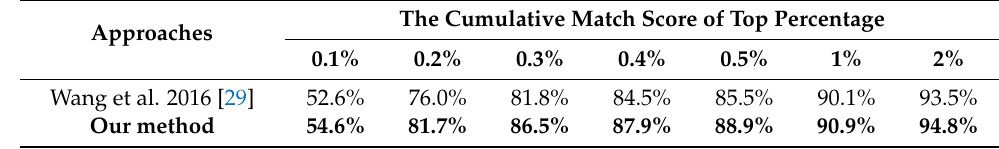
Table 3. Comparison with the manifold ranking based shoeprint retrieval method.